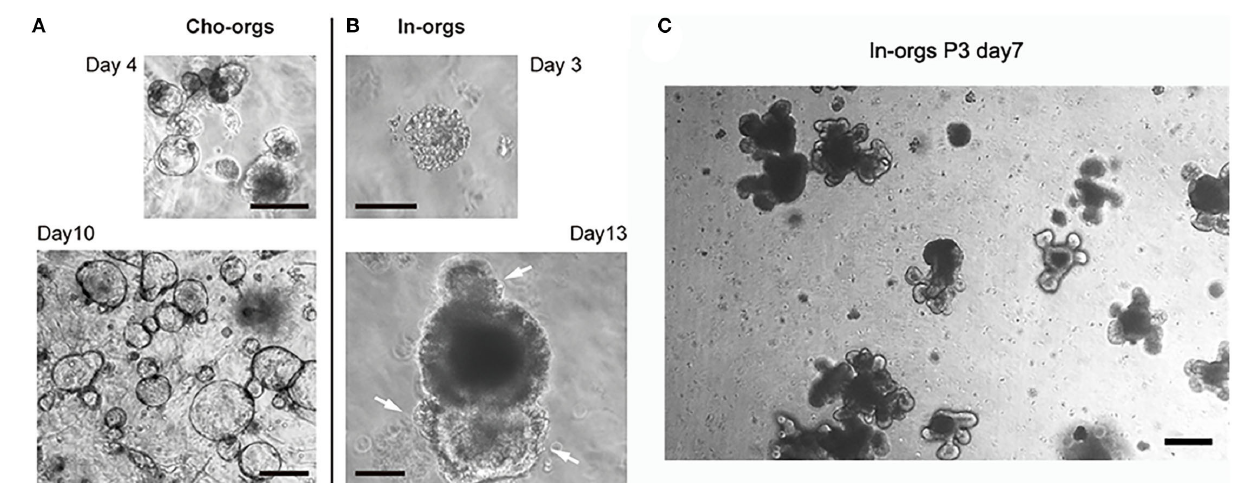
FIGURE 3 | Development of cho-orgs and in-orgs. Cholangiocytes (bile ducts) and crypts from the small intestine embedded in Matrigel developed into cyst-like structures. (A,B) Cells congregated in the cysts of in-orgs (day 3) and were outside the cho-orgs (day 4); after culturing for 10–13 days, the cho-orgs (day 10) and in-orgs (day 13) increased in size, and the in-orgs developed three buds (white arrow) to form a mature structure (bar, 100 µ m). (C) Mature in-orgs after culturing for 7 days after passage, they were bud-shaped and had aggregated cell clumps in the organoids (bar, 100 µ